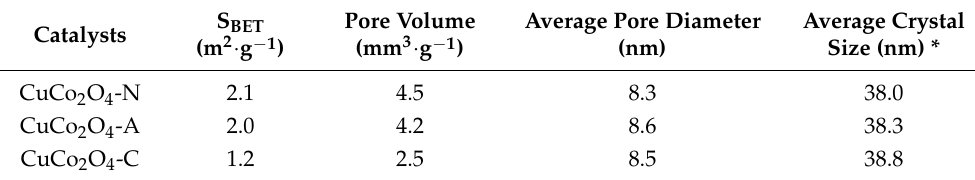
Table 1. Textural properties of the CuCo 2 O 4 - x ( x = N, A and C) catalysts. Catalysts